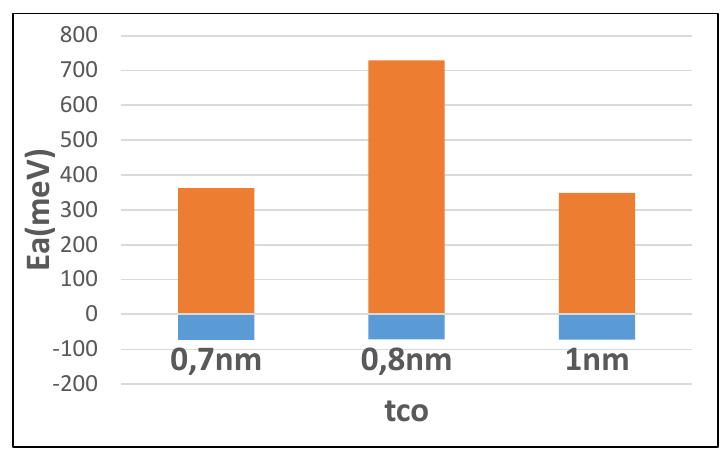
Figure 4 . Distribution graph of the energy barrier in each